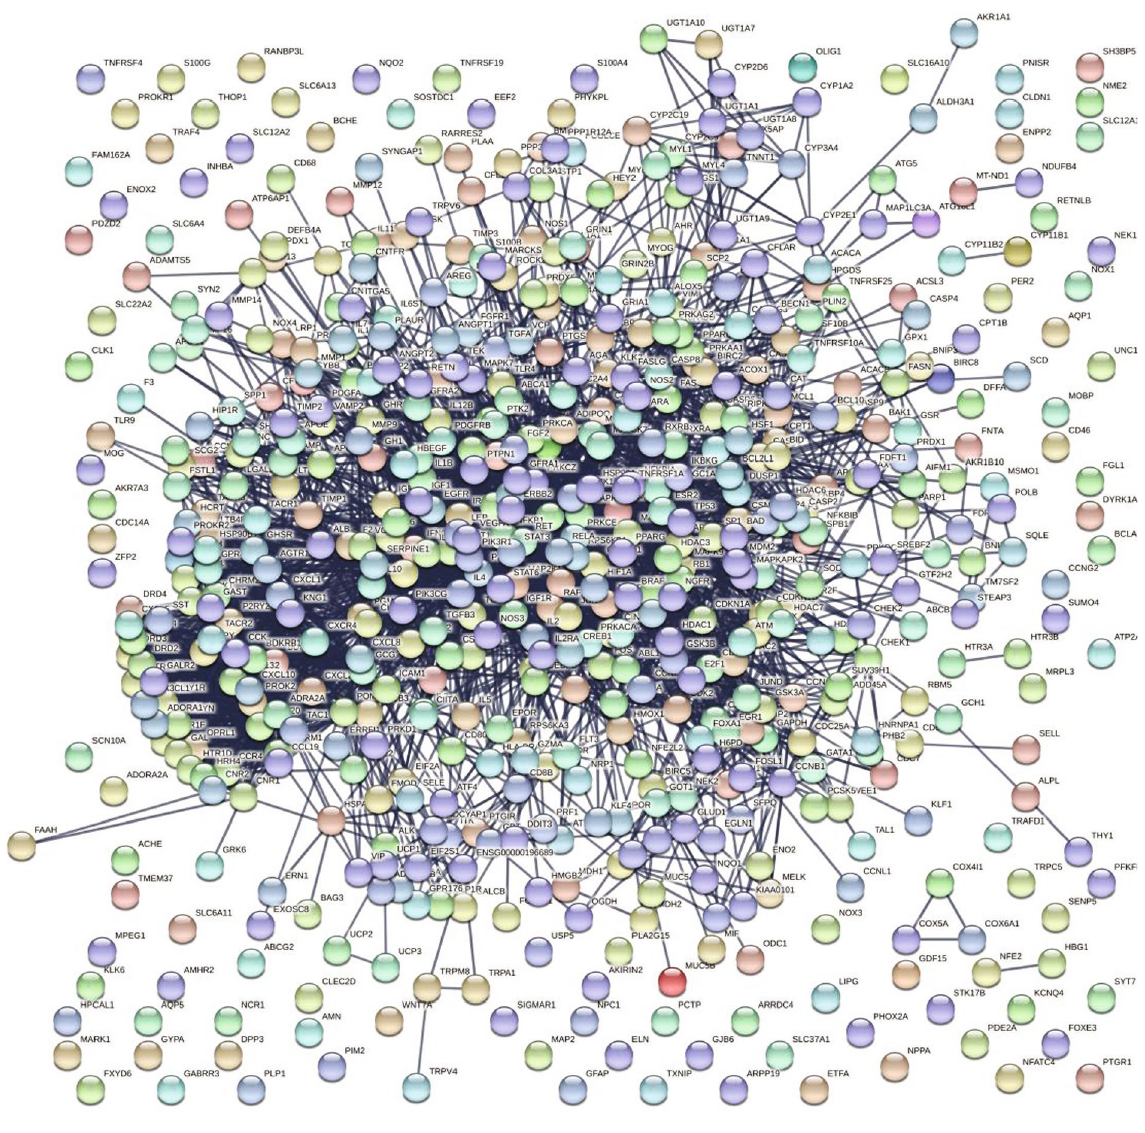
Figure 2: Construction of the PPI network for Cap against acute lung